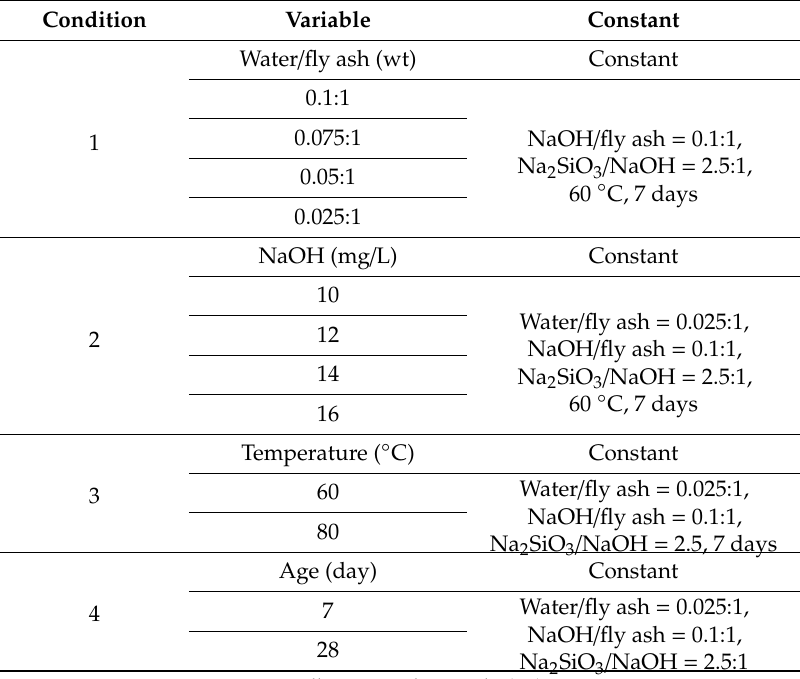
Table 1. Mix proportions per condition.